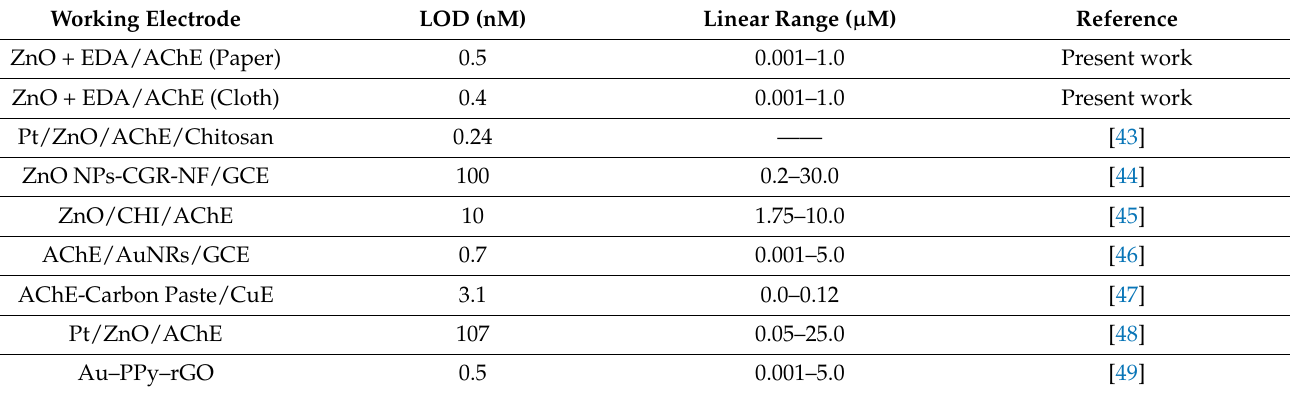
Table 3. Performance comparison of present work biosensors with literature